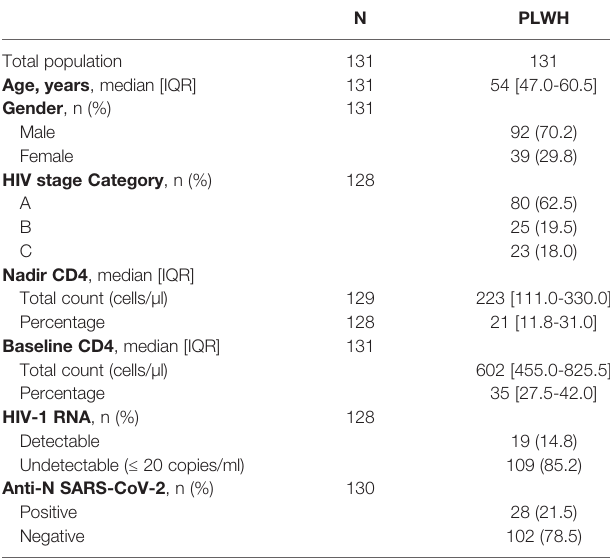
TABLE 1 | Baseline characteristics for